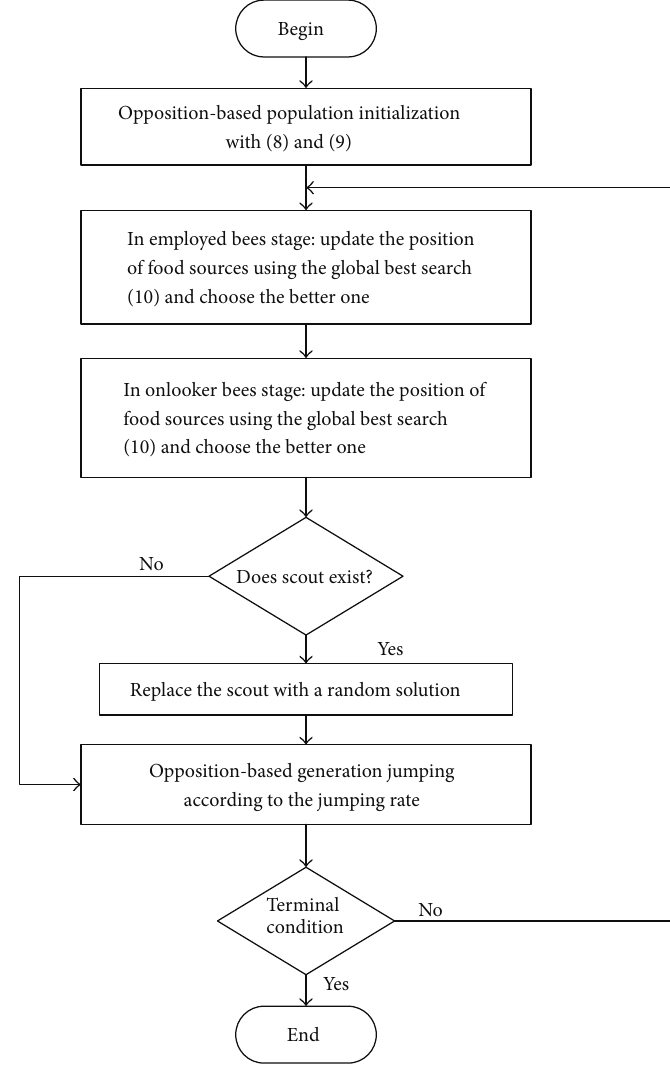
Figure 1: The flowchart of the proposed OGABC